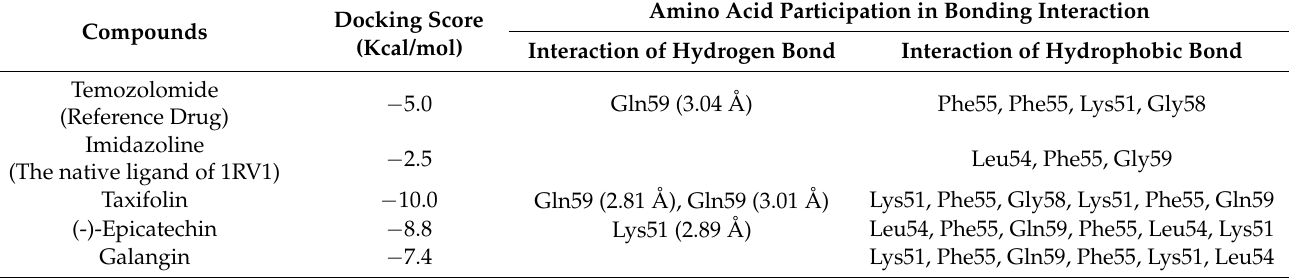
Table 3. Tabulated in docking score, molecular interactions among selected phytochemicals with the targeted